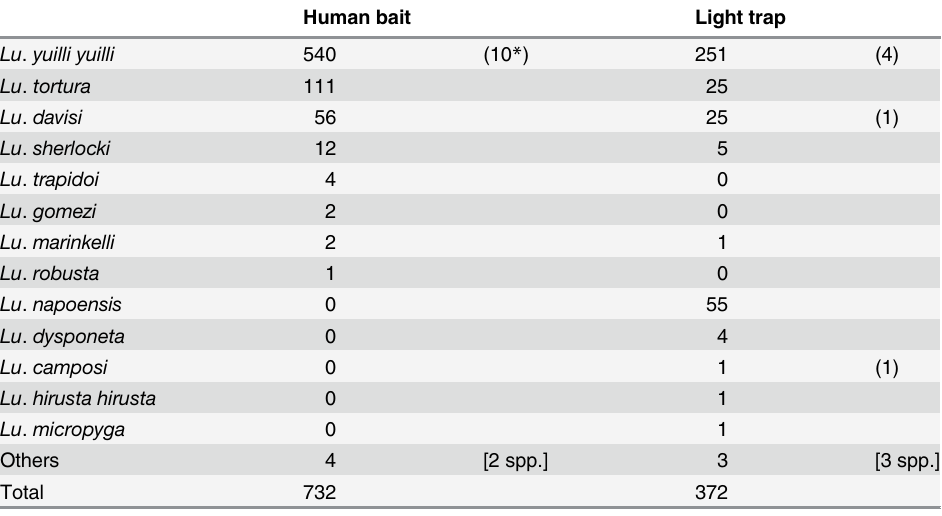
Table 2. Identification of sand fly species and detection of flagellates within individual sand flies by microscopic examinations. Human